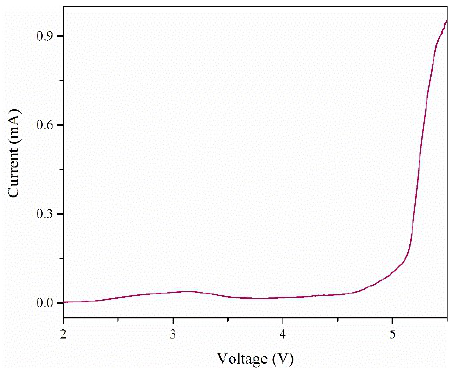
Figure 4. The electrochemical window of poly(OPal-MMA) (poly(OPal-MMA)- 5 ).